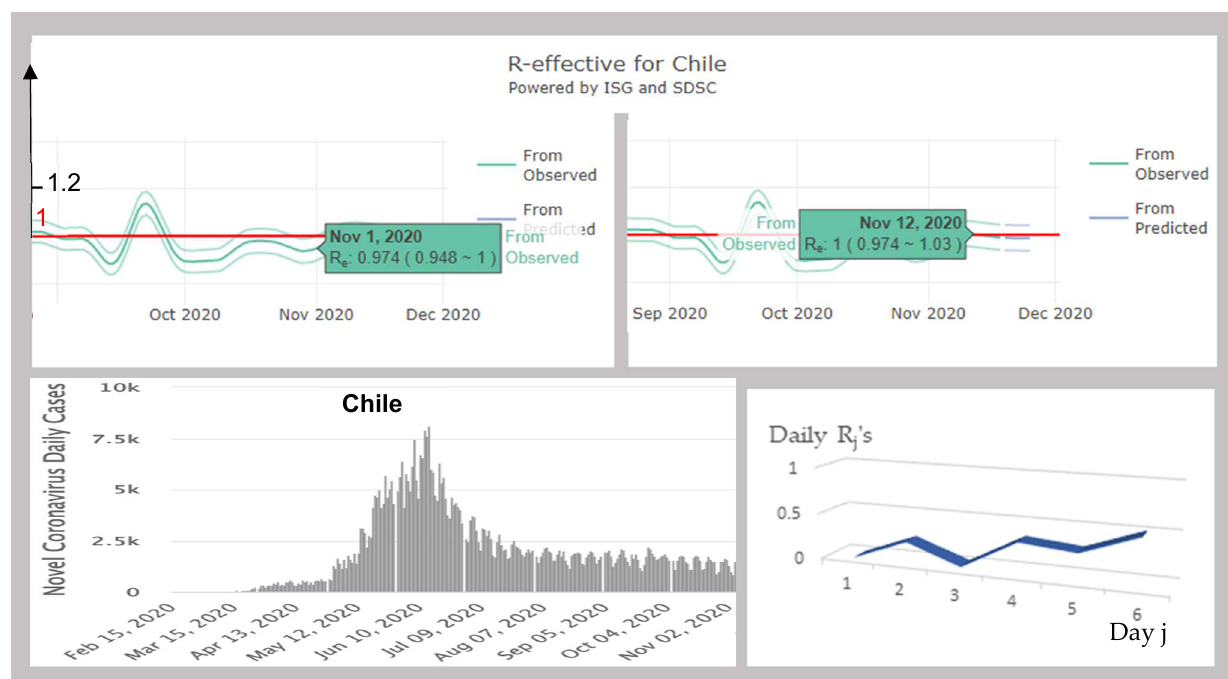
Figure 4. Top : estimation of the effective reproduction number R e ’s for the 1 November and the 12 November 2020 (in green, with their 95% confidence interval) [28,29]. Bottom left : Daily new cases in Chile between 1 November and 12 November [30]. Bottom right : U-shape of the evolution of the daily R j ’s along the infectious 6-day period of an